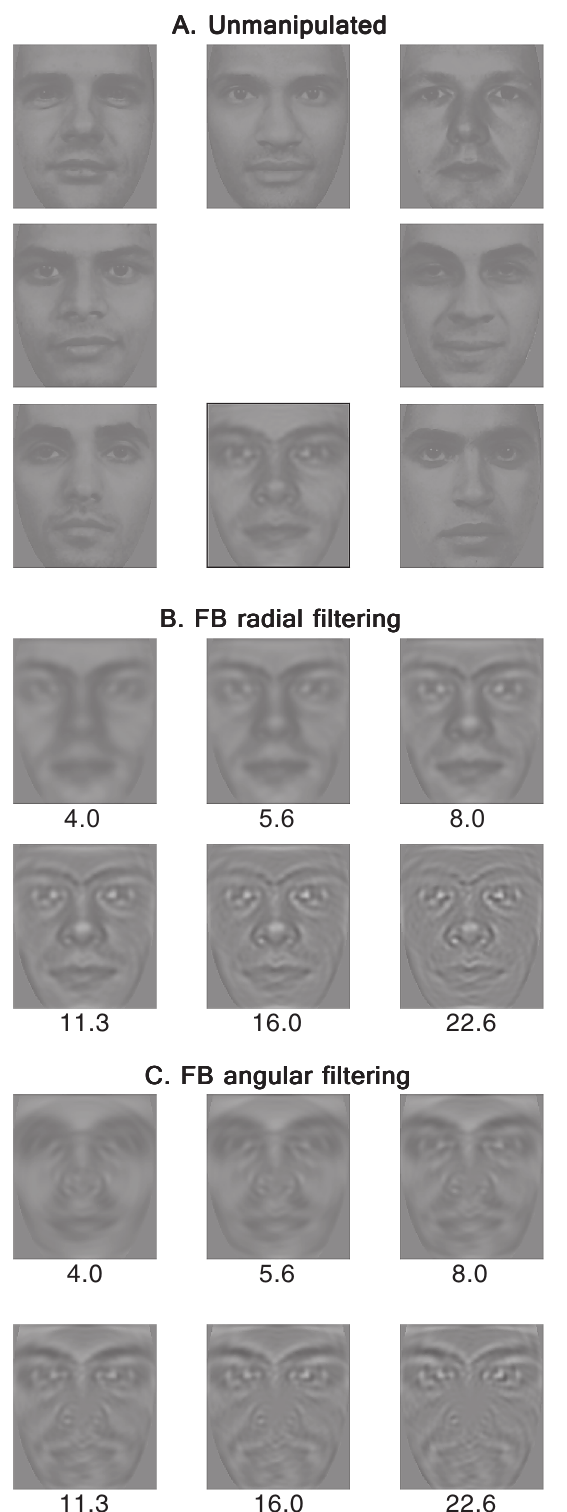
Figure 2. Face stimuli used in the experiments. All images are set to the same mean luminance and contrast variance. A, The original normalized face images in the spatial layout displayed to the observers. B, Radial and C, angular filtering of the image defined by a black contour line in A. Numbers below the images indicate the respective central frequency of the